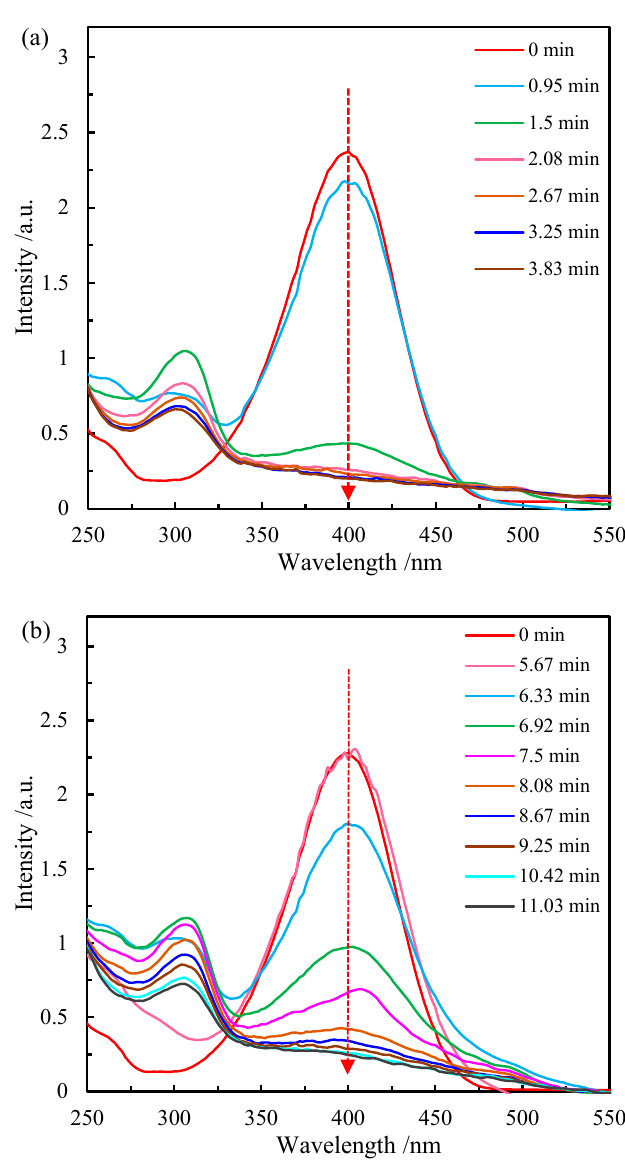
Figure 5. The UV–vis absorption spectra during the catalytic reduction of p-NP with ( a ) CoOOH/rGO and ( b ) pure CoOOH at different reaction times. Reaction conditions: Initial p-NP concentration ( C p-NP ) at 0.125 mmol/L, molar ratio of NaBH 4 to p-NP at 100, catalyst weight ( m cat ) at 0.2 mg.